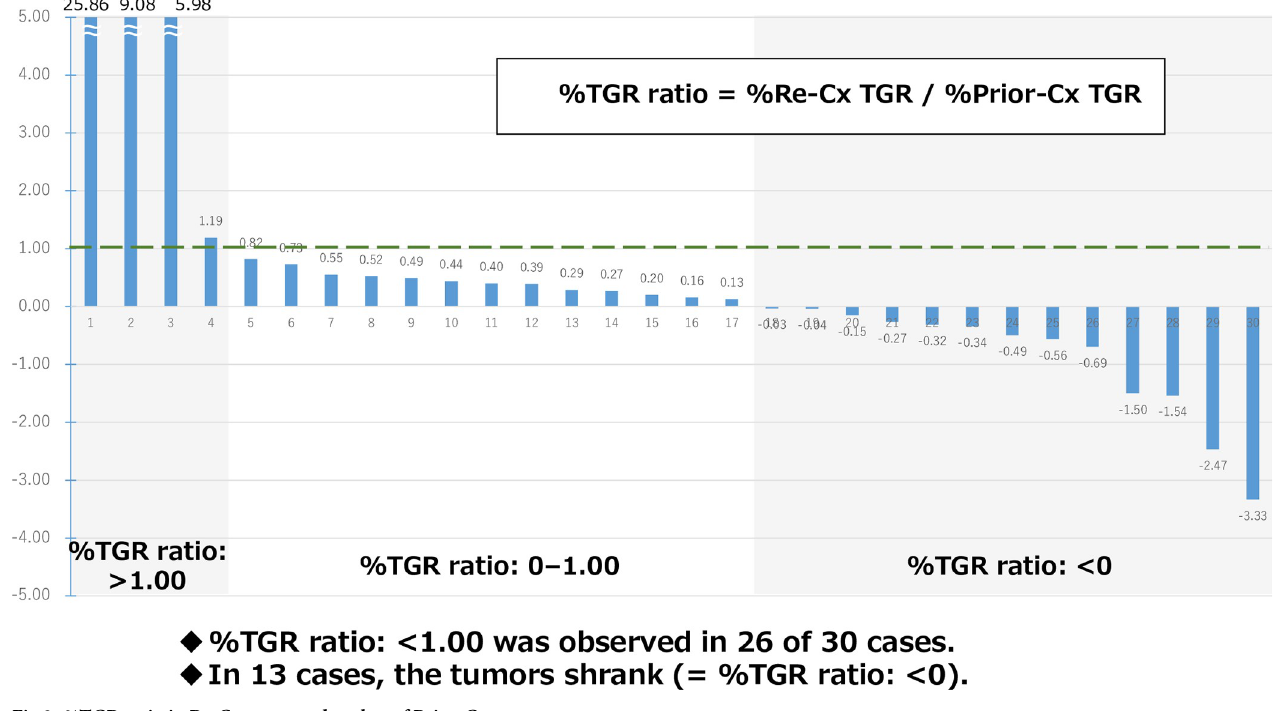
Fig 2. %TGR ratio in Re-Cx compared to that of